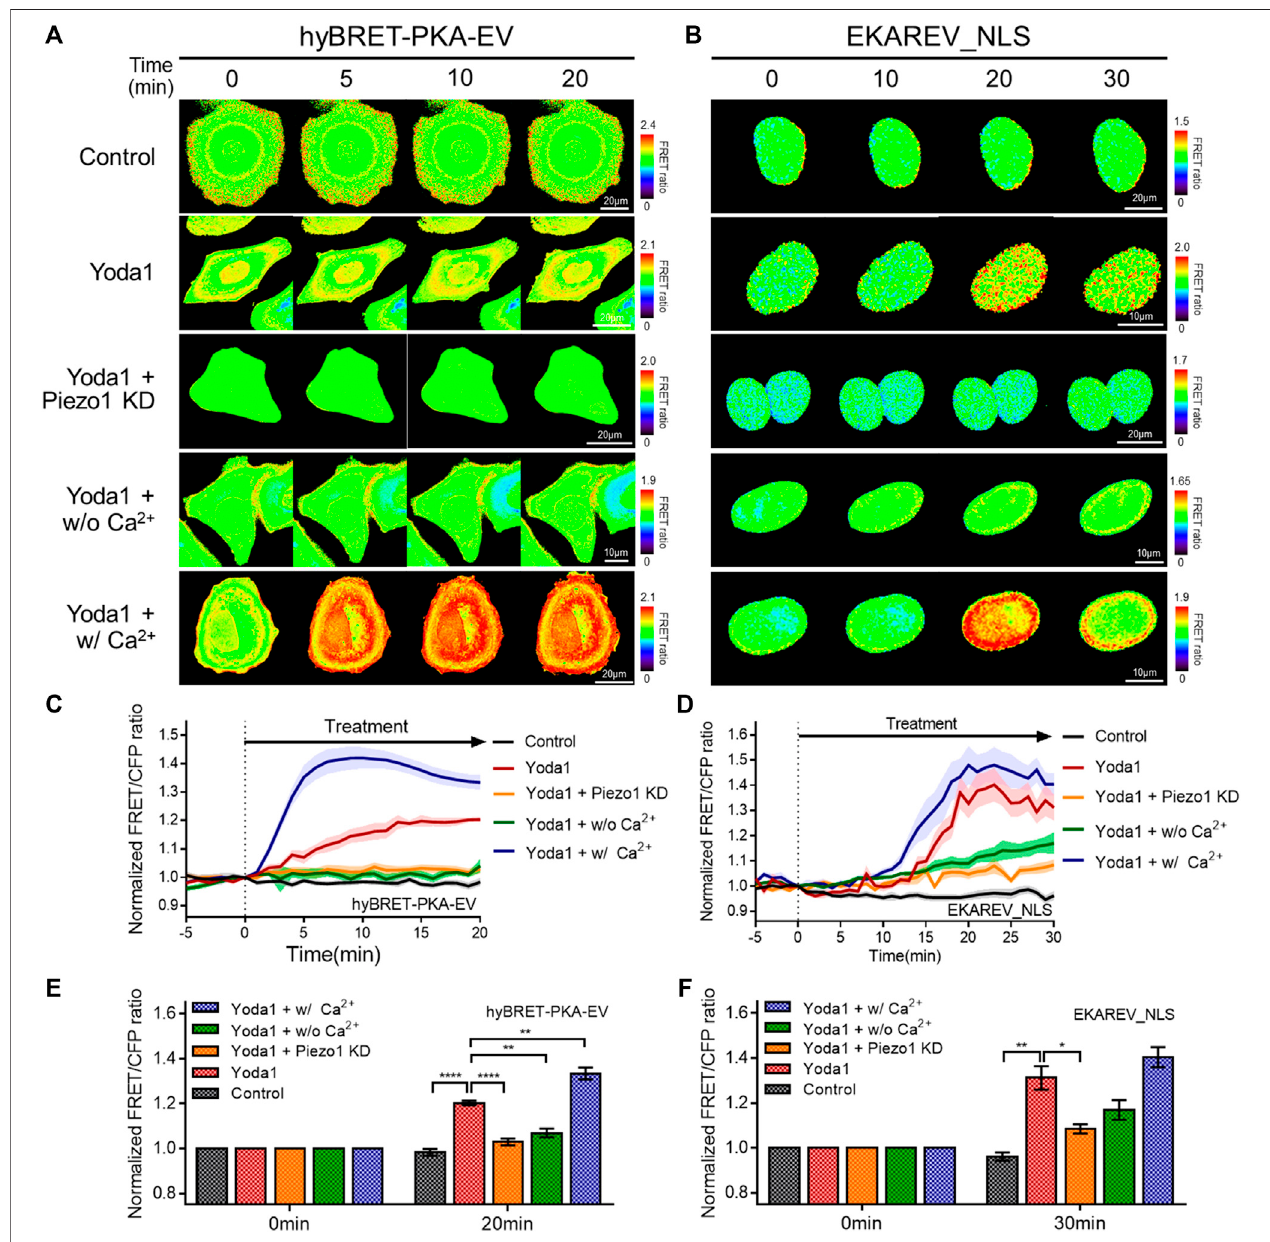
FIGURE 6 | Effects of Piezo1-induced cytosolic calcium increase on PKA and ERK activity. (A,B) Time-lapse FRET images of the (A) hyBRET-PKA-EV and (B) EKAREV_NLS in MCF-7 cells. Thecells were exposed tothe control[0.2% (v/v) DMSO]and Yoda1 (5 μ Mfor hyBRET-PKA-EVand 1 μ M forEKAREV_NLS)dissolved in CO 2 -independent culture medium (Yoda1 group), Ca 2+ -free medium (Yoda1 + w/o Ca 2+ group) and Ca 2+ medium (Yoda1 + w/Ca 2+ group), respectively. The Yoda1 + Piezo1 KD group was incubated in CO 2 -independent culture medium. The color scale bars represent the range of the FRET/CFP emission ratio determined using the biosensor. Hot and cold colors indicate high and low (A) PKA and (B) ERK activity, respectively. (C,D) The time courses represent the average of the normalized FRET/CFPemission ratiochangesof (C) hyBRET-PKA-EVand (D) EKAREV_NLS.Thelines aremeanvaluesofnormalized emission ratios,withdiluted colorsindicating the S.E.M ( n = 7). (E,F) The bar graph describes the mean values of the normalized FRET/CFP emission ratios of (E) hyBRET-PKA-EV and (F) EKAREV_NLS at the indicated times with error bars indicating the S.E.M ( n = 7, * p < 0.05, ** p < 0.01 and **** p < 0.0001, Student ’ s t -test).